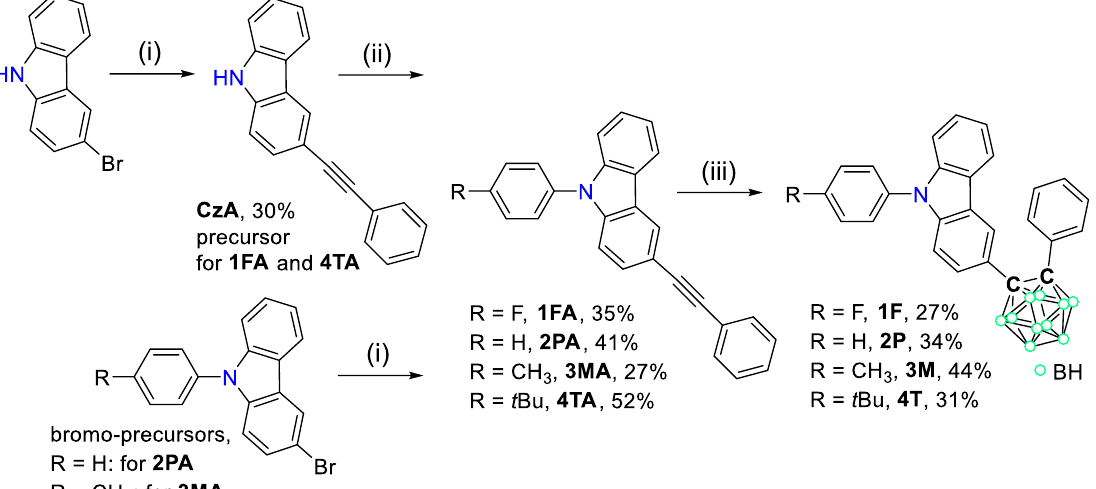
Figure 1. Synthetic routes for 9-phenyl-9 H -carbazole-based o -carboranyl compounds ( 1F , 2P , 3M , and 4T ). Reaction conditions: (i) phenylacetylene, CuI, Pd(PPh 3 ) 2 Cl 2 , toluene/NEt 3 (2/1, v / v ), 120 °C, 24 h; (ii) CuI, K 3 PO 4 , trans -1,2-diaminocyclohexane, 1-fluoro-4-iodobenzene (for 1FA ) or 1-bromo-4- tert -butylbenzene (for 4TA ), 120 °C, 24 h; (iii) B 10 H 14 , Et 2 S, toluene, 120 °C, 72 h.